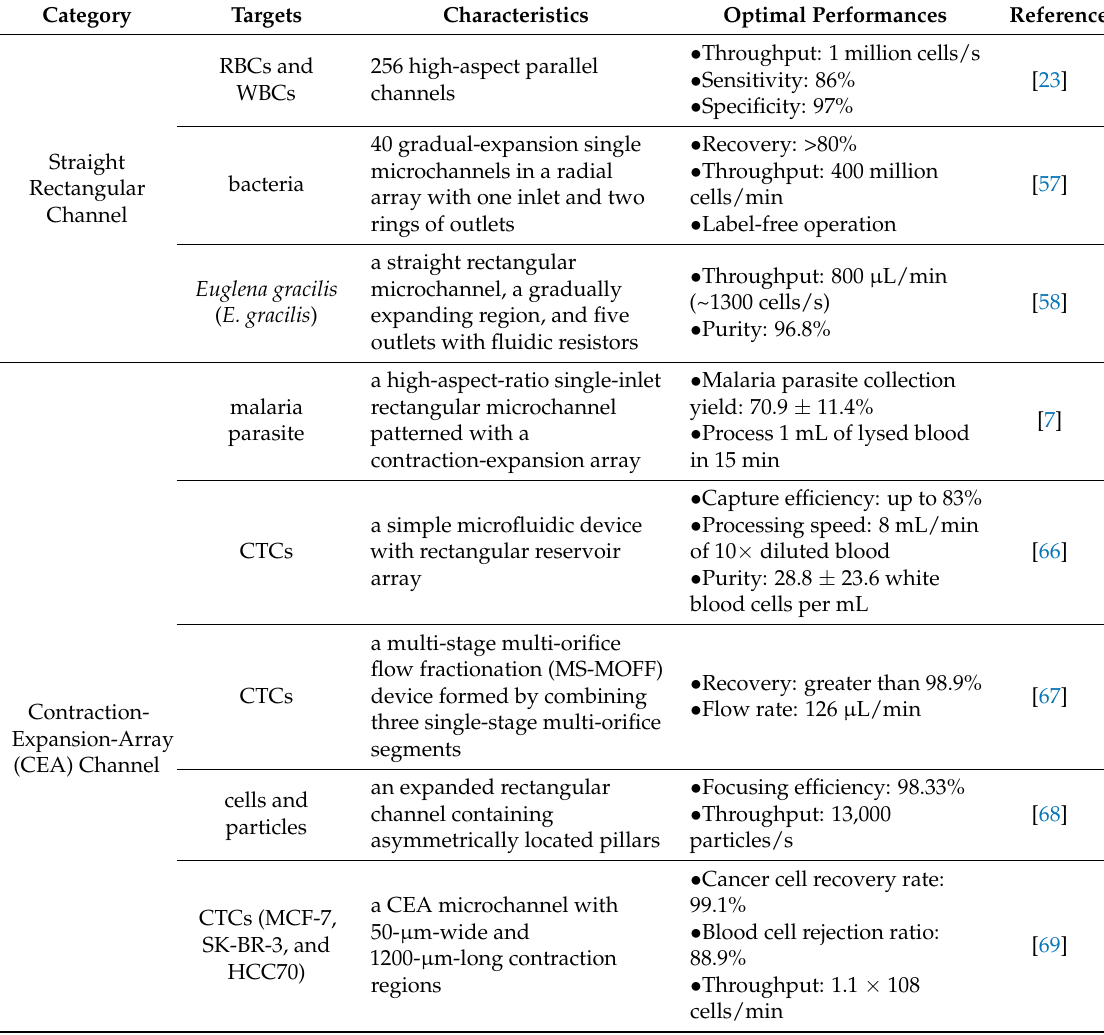
Table 2. Typical progress of straight-channel inertial